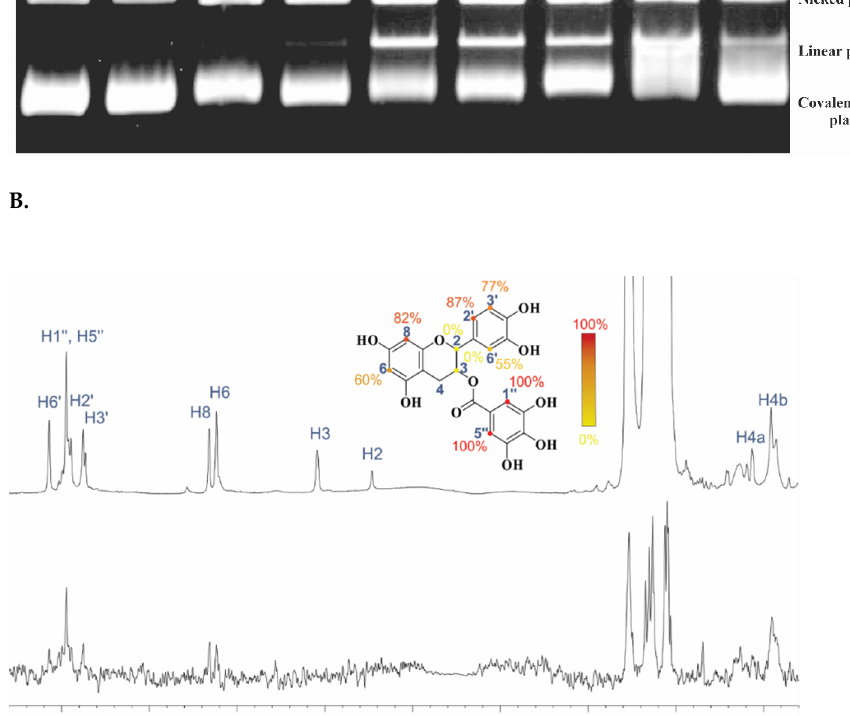
Figure 6. ( A ) Gel image of the first run of the topoisomerase II α competitive cleavage assay. The assay was performed at 4 different concentrations of compound 6 (0.05, 0.5, 5.0, and 10 µ M) in the presence of 50 µ M etoposide. ( B ) 1D 1 H STD NMR spectra for compound 6 recorded at topoisomerase II α :ligand ratio of 1:100 and 600 MHz. The molecular structure illustrates the proton nomenclature and color-coded relative degrees of saturation of the individual protons. The STD amplification factors were normalized to the intensity of the signal with the largest STD effect. Reference STD spectra (above) with proton assignment and difference STD spectra (below) are shown. Water signals (4.63 ppm) were removed by the processing filter. H2 and H3 proton signals exhibit decreased intensity in the reference spectrum due to interference of water suppression applied at 4.63 ppm. H4a and H4b proton signals are overlapped with DTT proton signals; therefore, the relative STD amplification factors could not be determined. Proton signals between 3.5 and 3.8 ppm belong to the glycerol and are not shown in full size. Proton signals were calibrated to the DSS signal at 0.0 ppm.